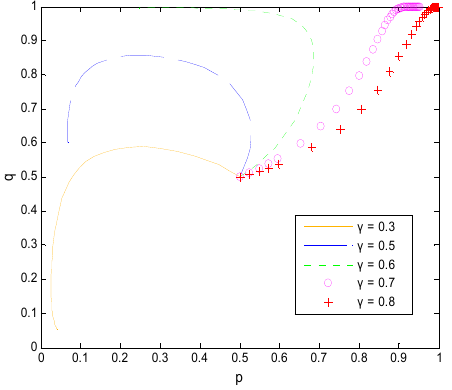
Figure 10. The evolution process of the change of γ .